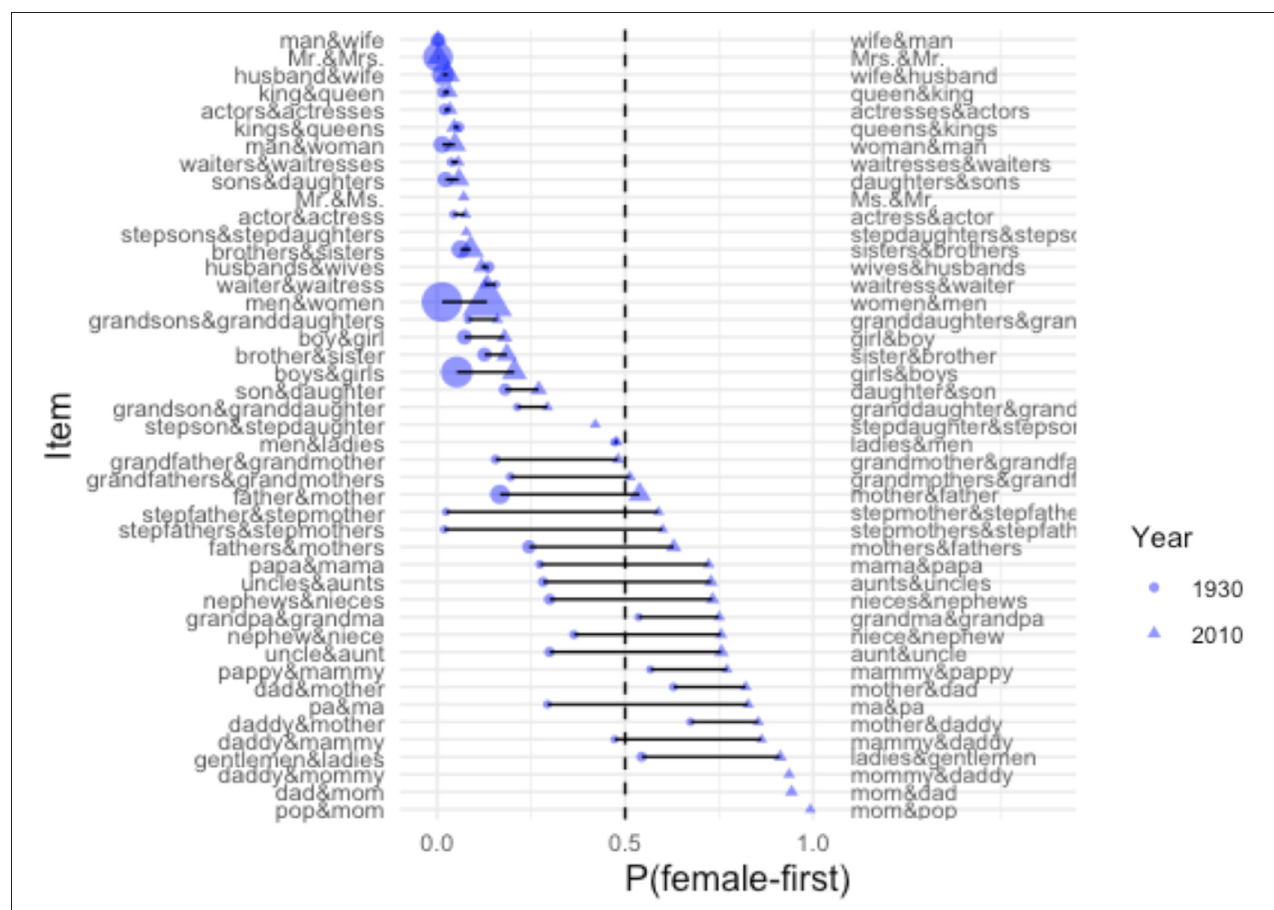
FIGURE 2 | The probability of female-first order for 45 gendered binomials at two time points: 1930 (circles) and 2010 (triangles), based on data from Google Books N-grams. The size of the endpoints represents the frequency of the binomial (in either order). Time points (and lines) are omitted for items below a threshold frequency of 0.05 per million